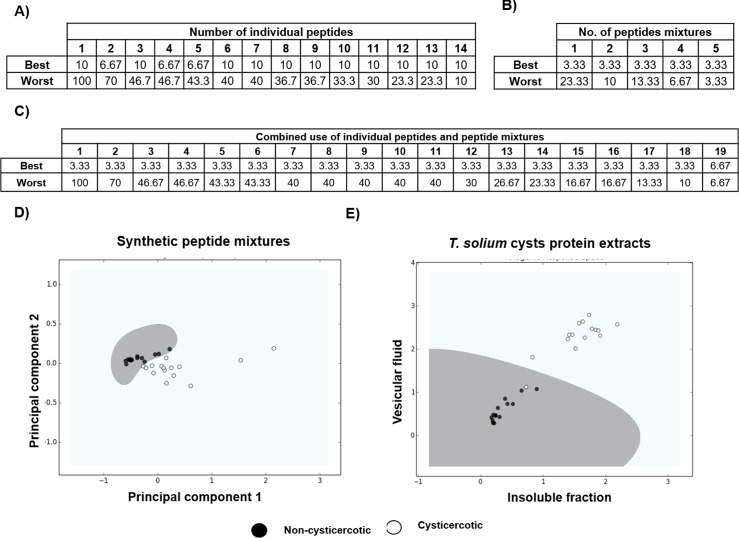
Antigenic response space.The raw optical densities were analyzed using machine-learning methodologies. We determined the performance of (A) individual peptides measurements, (B) peptide mixtures measurements and (C) the combination of both strategies. Best/worst refers to the percentage of error (taking into account our n = 30; an error of 10 implies that three pig sera were not discriminated). Visual representation of the antigenic response space for multiple antigen testing (D) and T. solium cysts protein extracts (E).